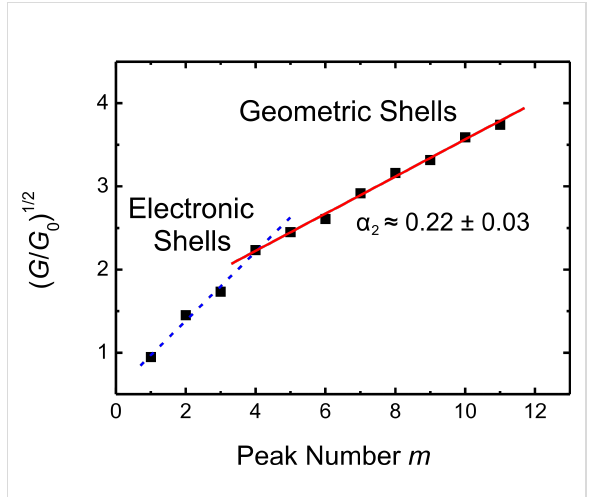
Figure 4: ( G / G 0 ) 1/2 at the positions of the maxima observed in Figure 3 versus their sequentially numbered index. We observe two ranges: One up to the fourth maximum (dashed line) and another one from the fourth to the eleventh maximum with a slope of α 2 ≈ 0.22 ± 0.03 (solid line). This behavior indicates two different mecha- nisms configuring the contact, the experimentally determined value of α 2 being in excellent agreement with the value predicted by calcula- tions.